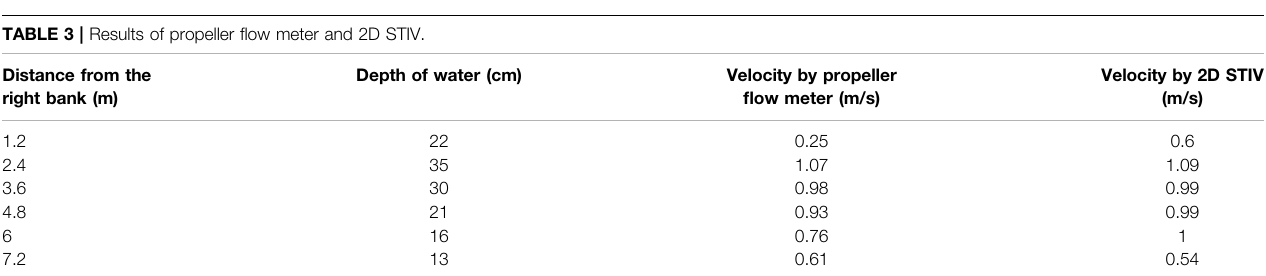
TABLE 3 | Results of propeller fl ow meter and 2D STIV. Distance from the right bank (m)